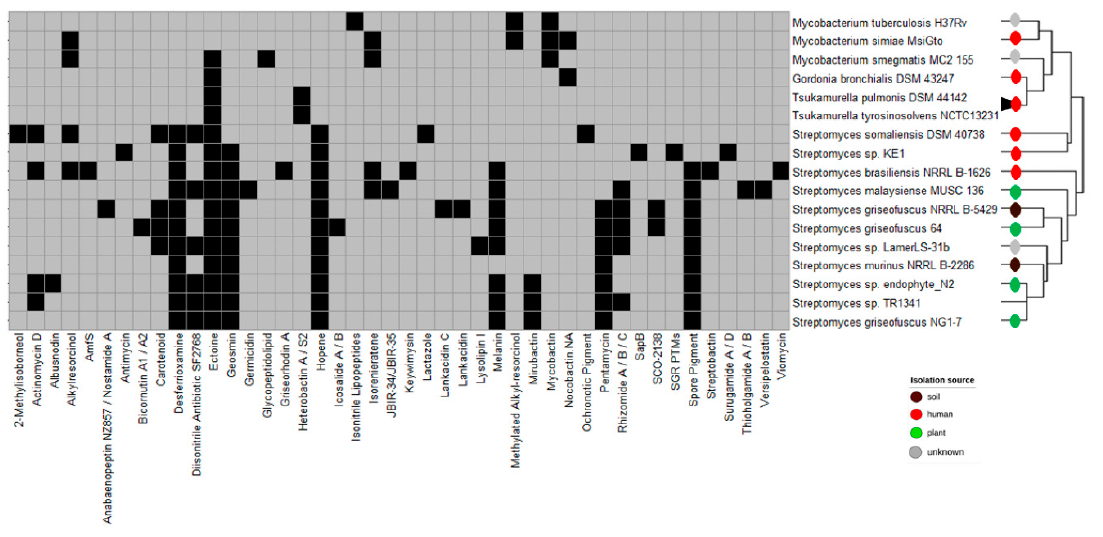
Figure 4. Biosynthetic gene clusters (BGCs) predicted by antiSMASH with more than 50% of the genes showing similarity to a known BGC. Black squares indicate presence, while grey indicates absence. The isolation source of the organisms is shown with the colored circles at the tip of the branches.